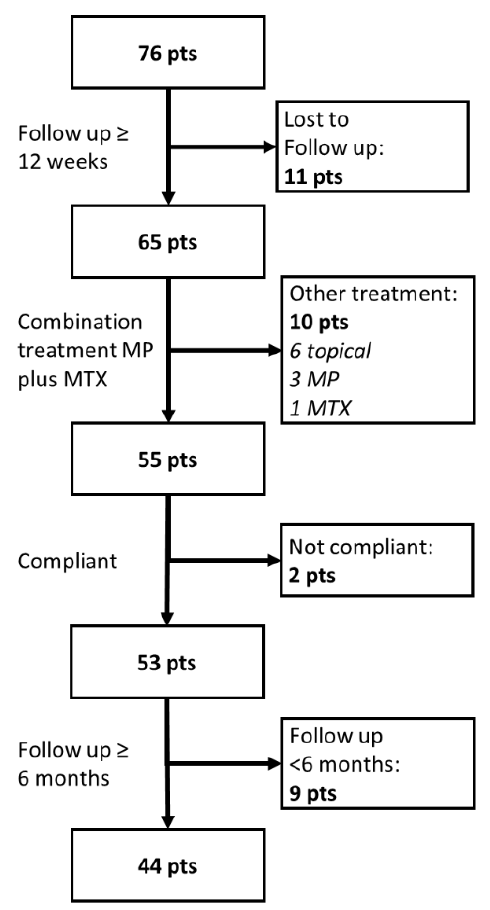
Figure 1. Flow chart of the inclusion strategy of the bullous pemphigoid patients. MP: methylpred- nisolone; MTX: methotrexate; topical: topical glucocorticoids. Short-term efficacy of the treatment . For most of the patients ( n = 38), MP Table 1. Core demographic and treatment parameters of the cohort ( n = 53, Total ). In addition, a comparison of patients taking dipeptidyl peptidase 4 inhibitor ( n = 24) or not ( n = 29) at the time of bullous pemphigoid diagnosis.